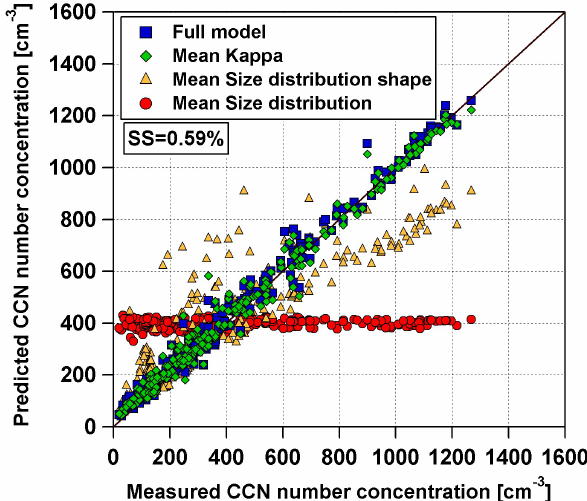
Fig. 6. Predicted vs. measured CCN number concentration for am- bient aerosol at SS =0.59% applying different simplifications in the calculation of the predicted CCN number concentration: full model (blue squares), time averaged κ (green diamonds), time averaged size distribution shape (yellow triangles), time averaged number size distribution shape and concentration (red points). The thin black line represents the one-to-one